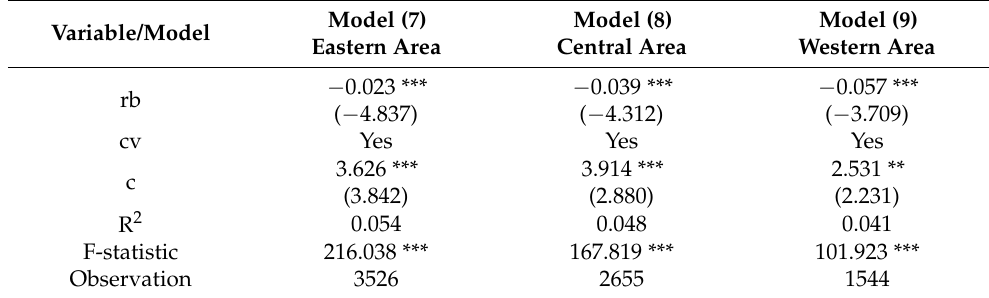
Table 6. Results of heterogeneous effect (geographical location).